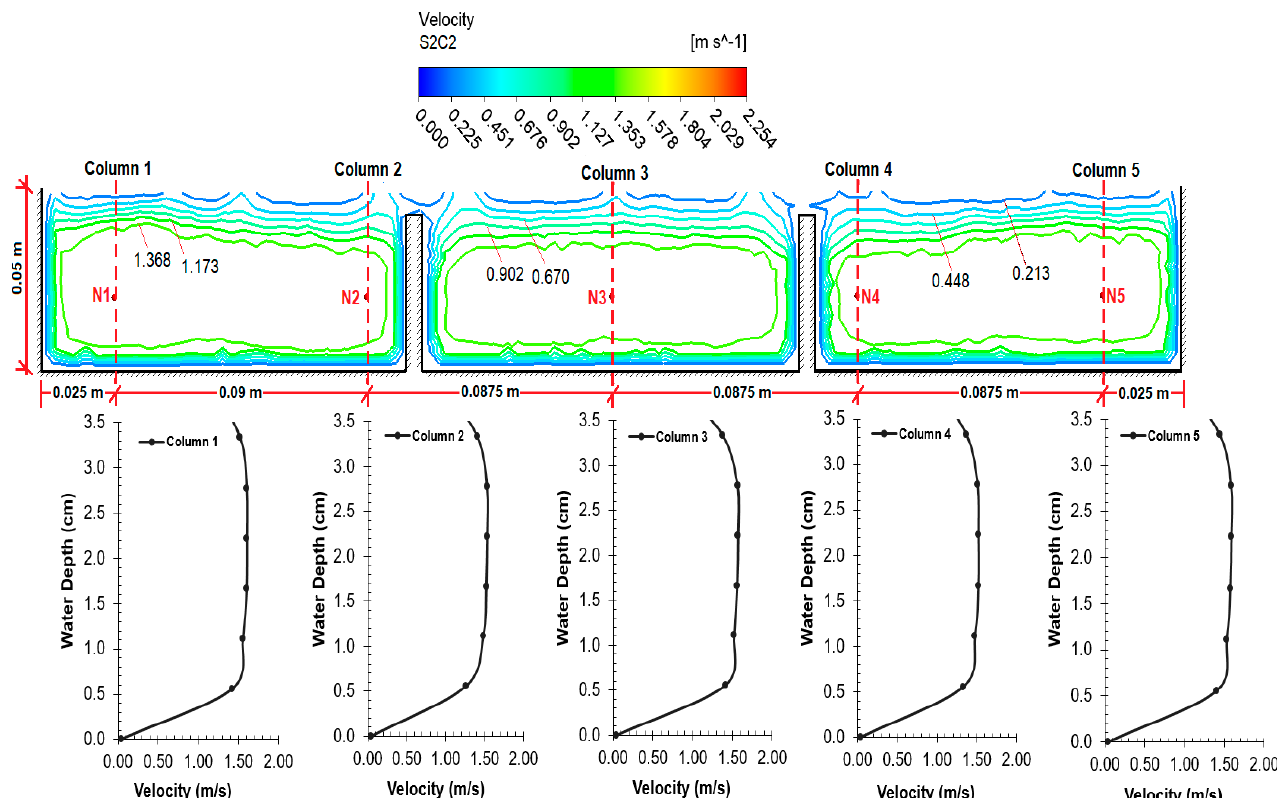
Figure 15. CFD velocity contours and depth-velocity distributions for Cross-section 1.